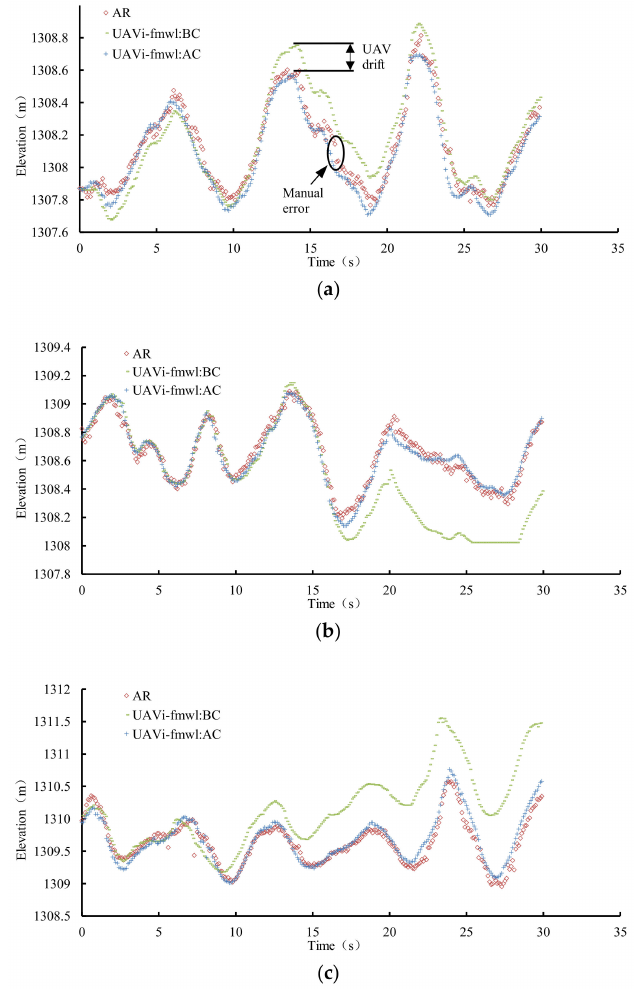
Figure 10. Trends contrast between artificial recognition (AR) data and field measurement of water level (UAVi-fmwl) data. ( a ) Q = 341 m 3 /s; ( b ) Q = 643 m 3 /s; and, ( c ) Q = 1249 m 3